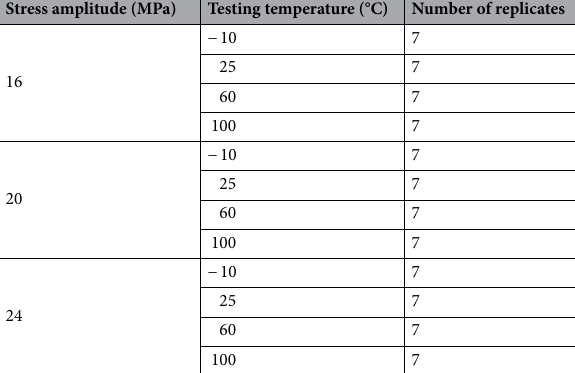
Table 1. The proposed test